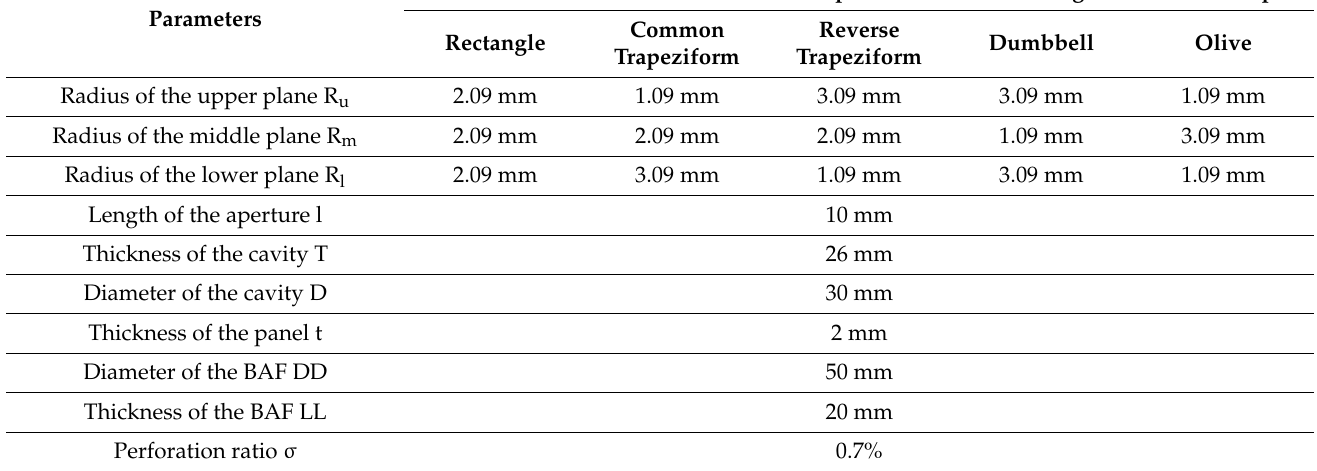
Table 1. The summarized parameters for two-dimensional rotational symmetric acoustic finite element